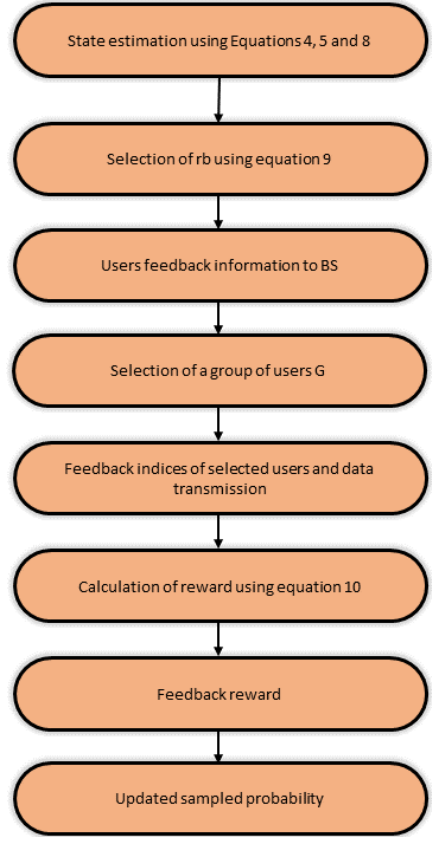
Figure 3. Flowchart of scheduling